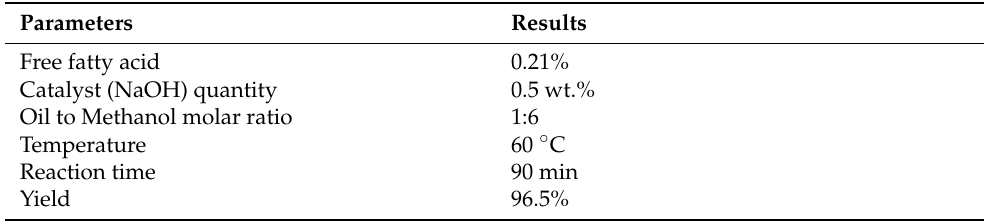
Table 1. Transesterification process parameters for palm